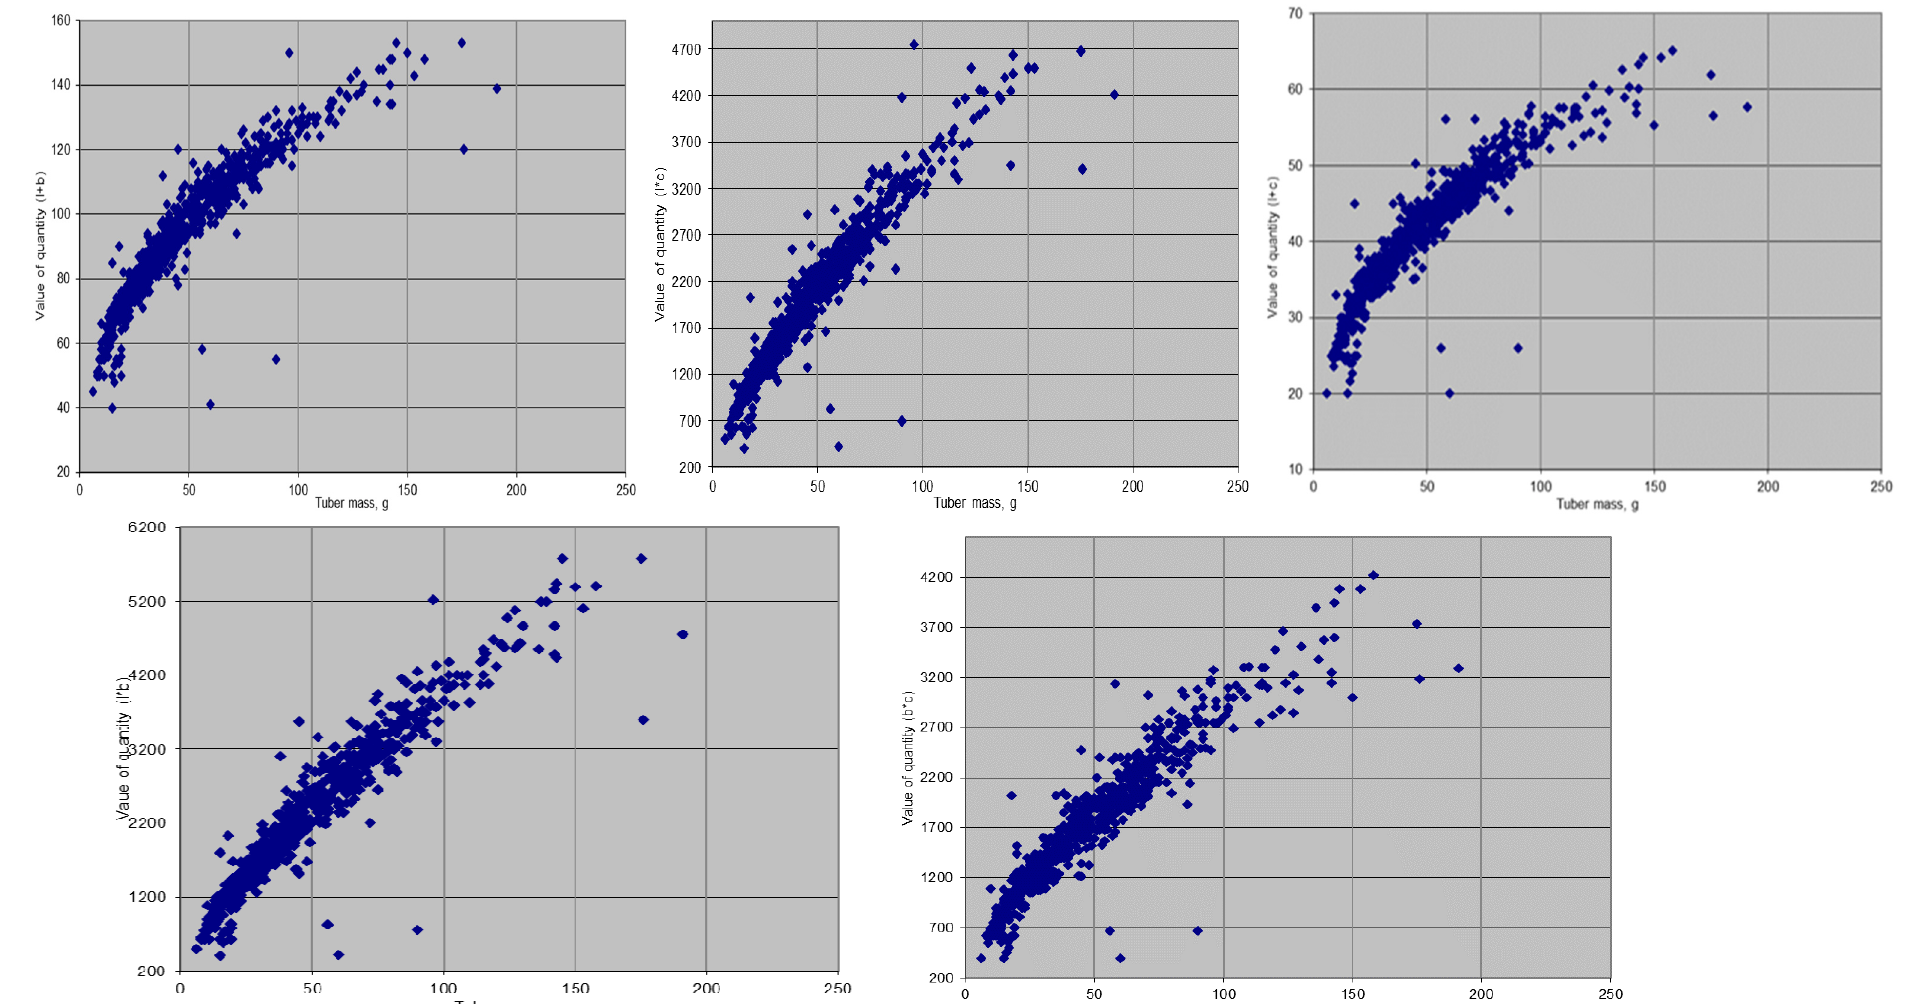
Figure 8. Scattering diagram of the results of the studies, determined by the values (l × b, l × c, b × c, l + b, l + c) of the correlations with the mass values.